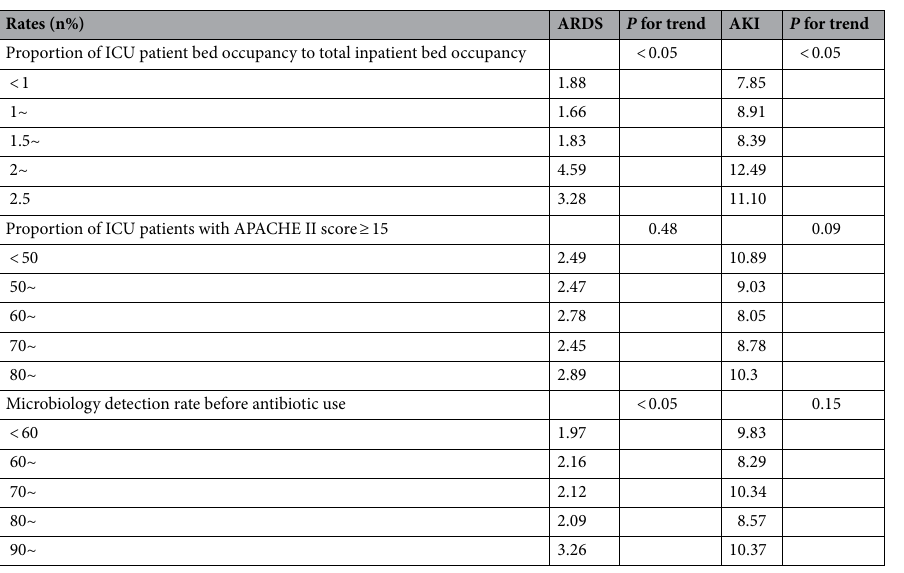
Table 4. Relationship between quality control indexes and acute organ failure. ICU, intensive care unit; APACHE, acute physiology and chronic health evaluation; ARDS, acute respiratory distress syndrome; AKI, acute kidney injury.